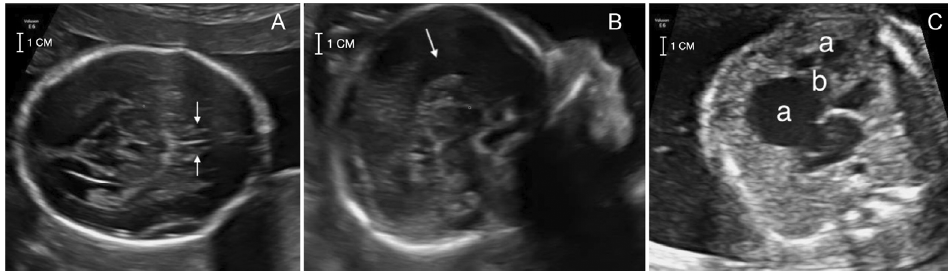
Figure 1. The II level ultrasound screening at 22 + 1 showing: ( A ) the absence of cavum of septum pellucidum (white arrows); ( B ) the corpus callosum agenesis (white arrow); ( C ) the heart anomaly with the prevalence of the right heart chambers ( a ) and displacement of the tricuspid valve structure ( b ), consistent with Ebstein’s anomaly.